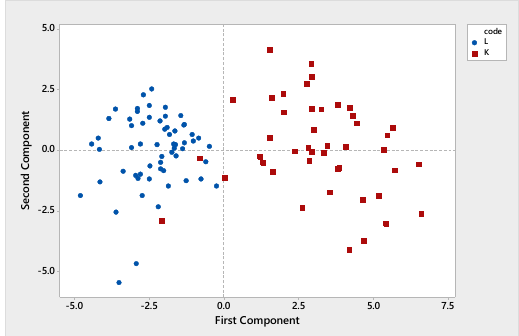
Figure 3. Score plot of PCA analysis based on 28 variables (combination of the sterolic and fatty acid data set) of the examined monovarietal olive oils. K corresponds to Koroneiki olive oils (red spots) and L to Lianolia Kerkyras olive oils (blue spots).